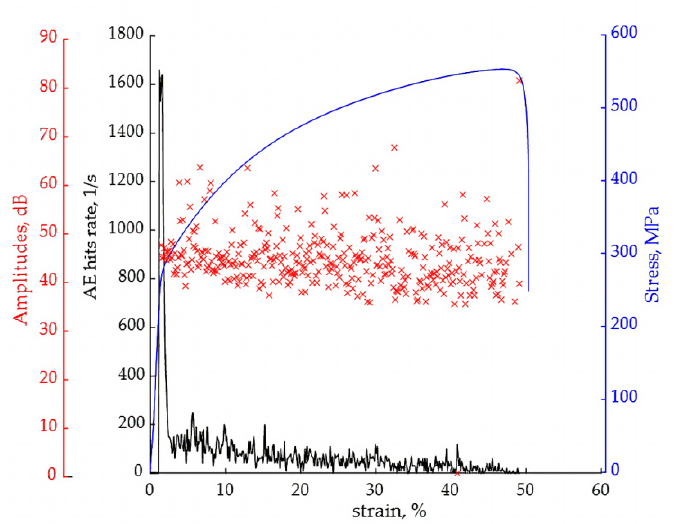
Figure 3. AE data recorded under tension of specimens made of 12Kh18N10T austenitic steel.